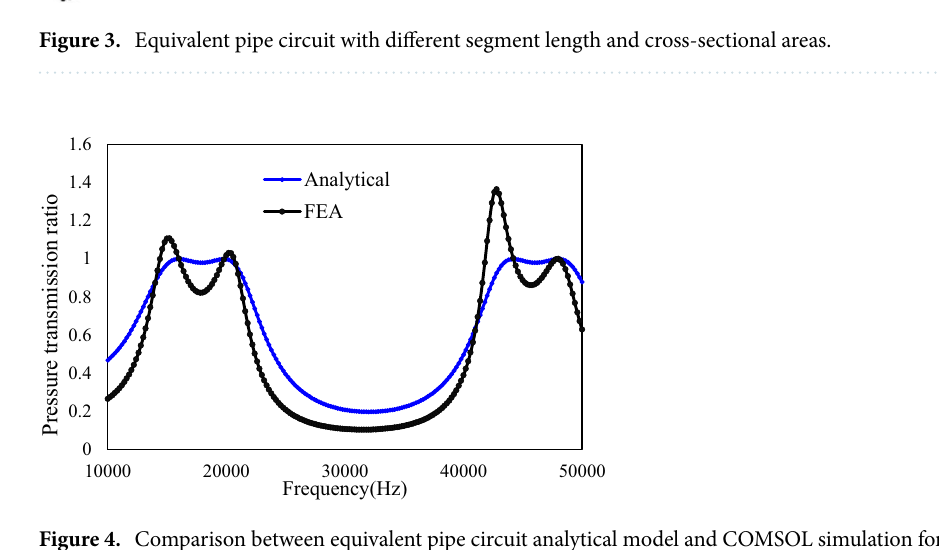
Figure 4. Comparison between equivalent pipe circuit analytical model and COMSOL simulation for straight pipe